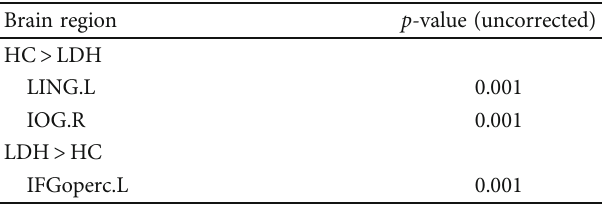
Table 3: Brain regions with signi fi cant di ff erent degree centrality (DC) between LDH induced nerve root(s) compression and healthy control groups.